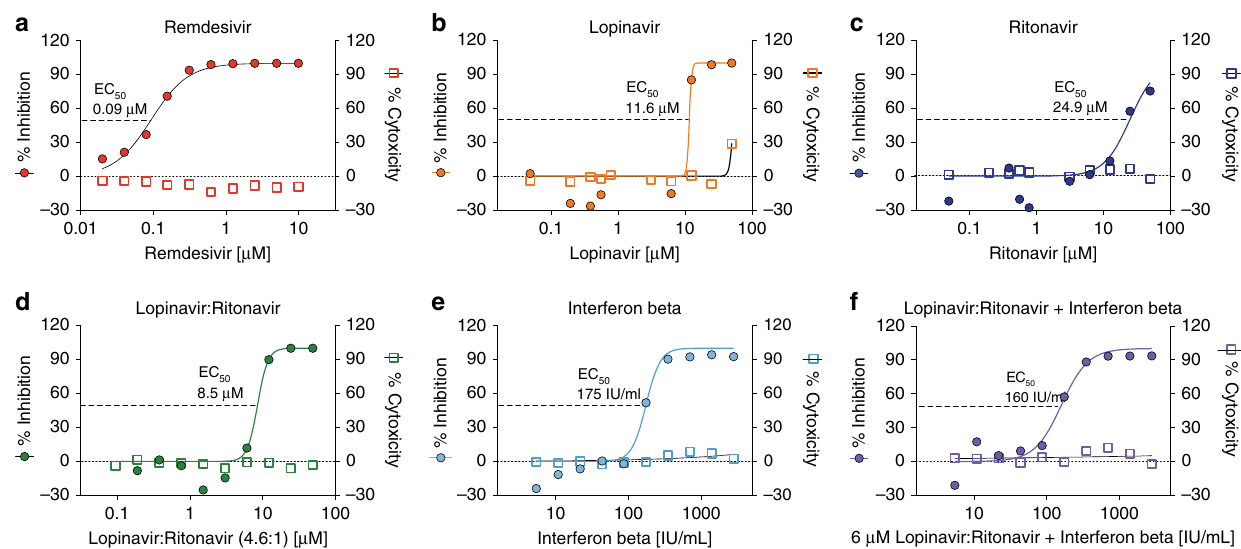
Fig. 1 RDV and IFNb have superior antiviral activity to LPV and RTV. Graphs depict mean % inhibition of MERS-CoV replication (left Y -axis) and % cytotoxicity (right Y -axis) of antivirals. Calu-3 cells were infected in sextuplicate with MERS-CoV nanoluciferase (nLUC) at a multiplicity of infection (MOI) of 0.08 in the presence of a dose response of drug for 48 h, after which replication was measured through quantitation of MERS-CoV – expressed nLUC. Cytotoxicity was measured in similarly treated but uninfected cultures via Cell-Titer-Glo assay. Representative data are shown from four independent